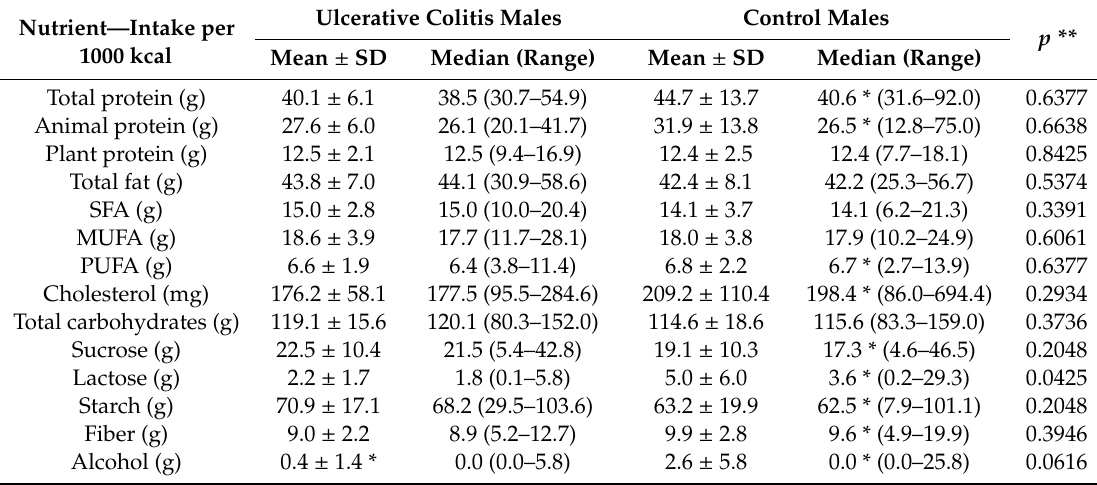
Table 2. The macronutrients intake per 1000 kcal in ulcerative colitis males and control males.